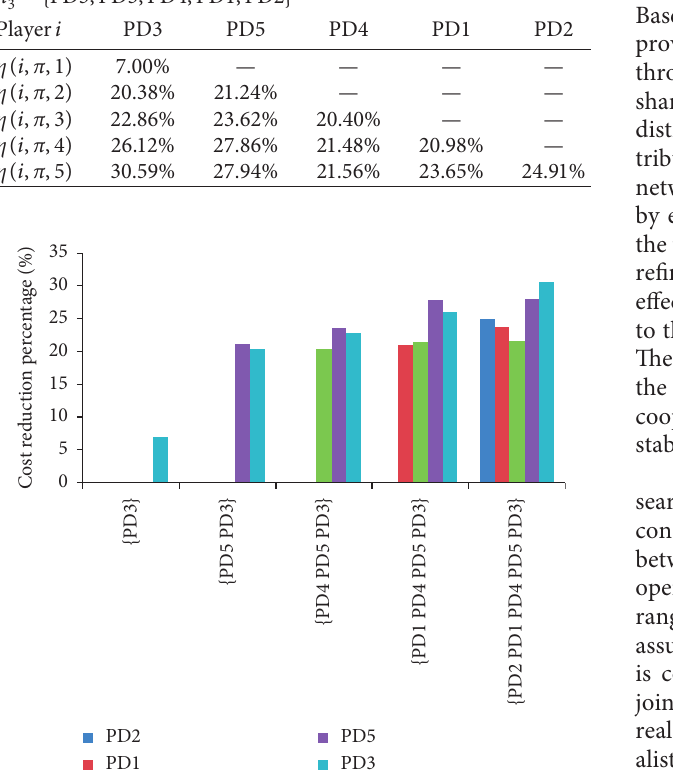
Table 14: Optimal membership sequence based on the SMP principle. � PD3 , PD5 , PD4 , PD1 , PD2 { π 3